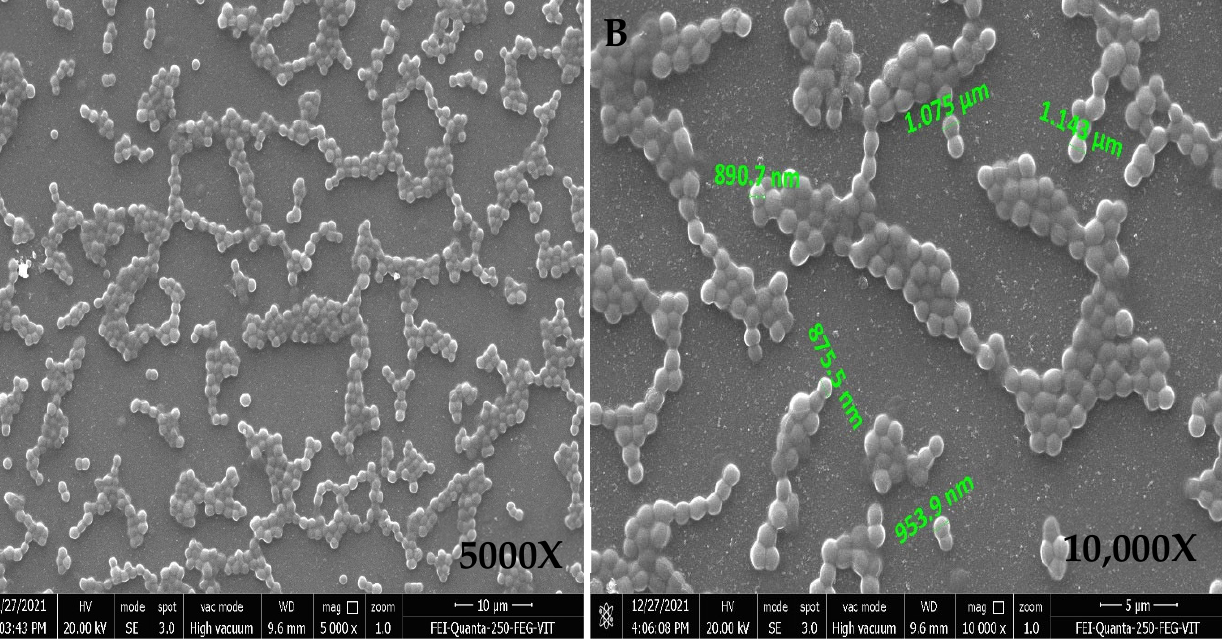
Table 2. Biochemical tests of Beijerinickia fluminensis VIT01 strain.